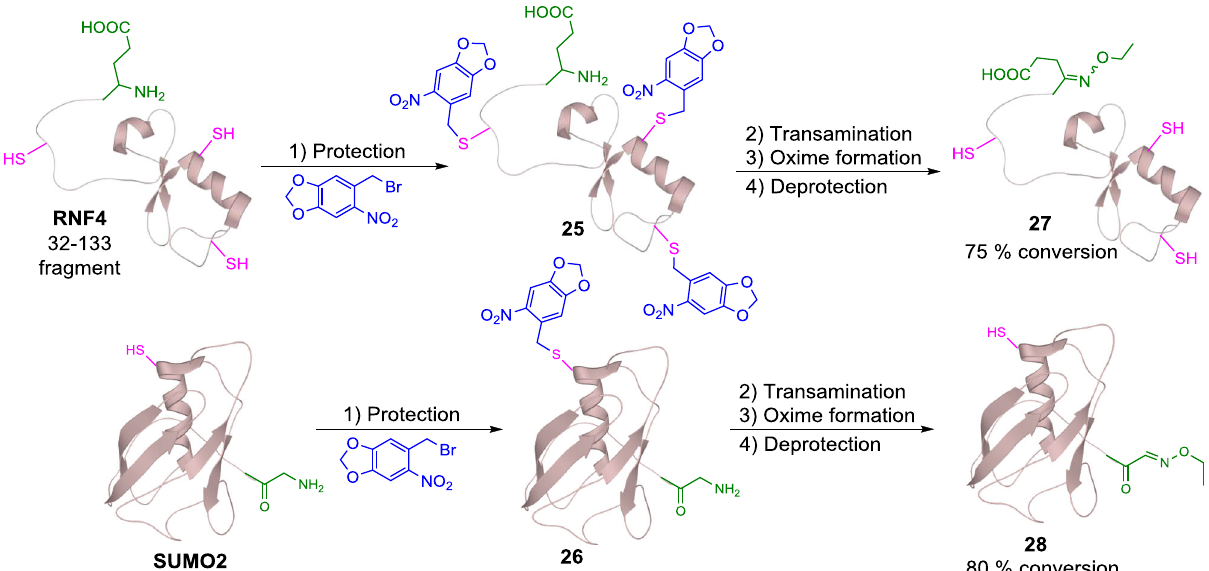
Fig. 5 Quinone-mediated transamination reaction with proteins bearing free-Cys residues. Reaction conditions for (1) photolabile protecting group installation: 2-nitropiperonyl bromide (100 equiv., sat.), 200 mM Na 2 HPO 4 , pH 6.5, 2 h, 25 °C; (2) Transamination: Ox1 (10 mM, sat.), 200 mM Na 2 HPO 4 , pH 6.5, 25 °C, 6 h for RNF4 25 ; 3 h for SUMO2 26 ; (3) Oxime formation: EtONH 2 ·HCl (100 mM), pH 4.0, 3 h, 25 °C; (4) Deprotection: hv ( λ = 365 nm),